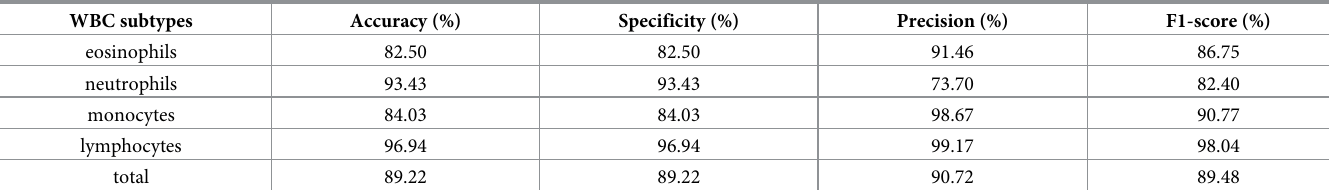
Table 6. Training results of different WBC